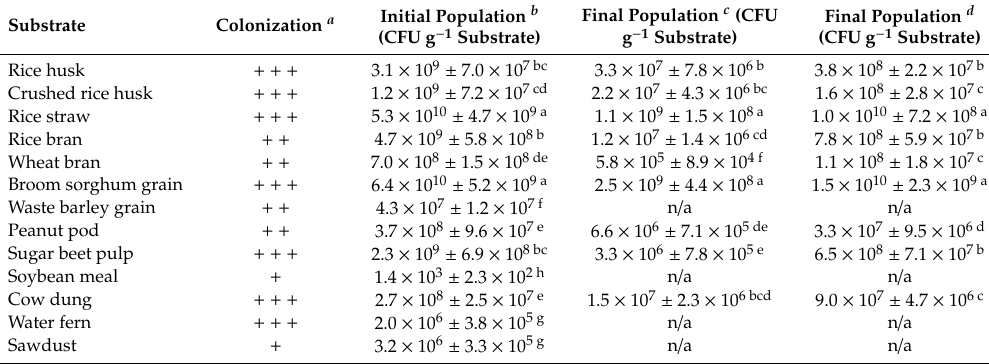
Table 1. Colonization of Trichoderma harzianum AS12-2 in di ff erent substrates and its initial and final